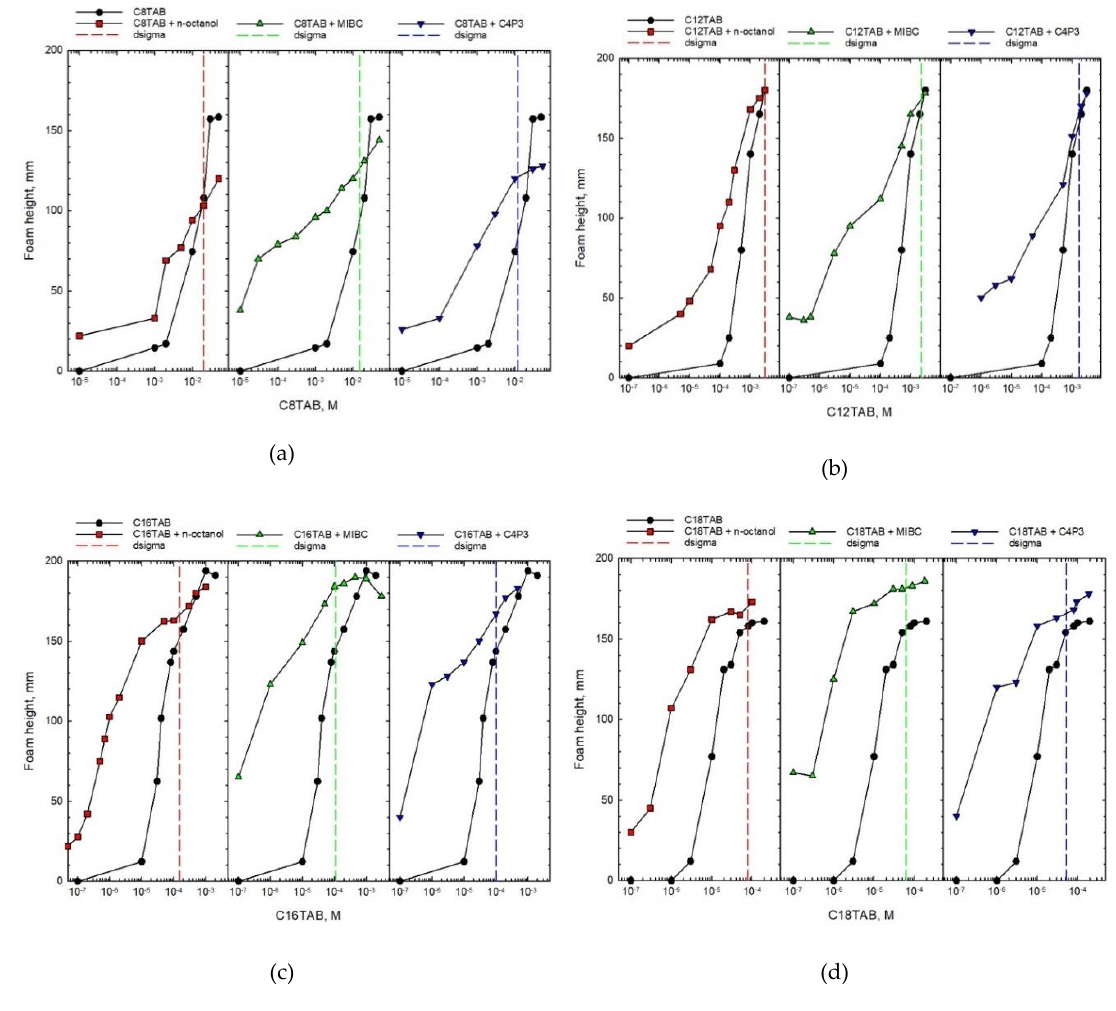
Figure 2. Foam height as a function of concentration of one-component solution and mixture of C n TAB (main component) with di ff erent non-ionic additives. The d σ (dsigma) values determined for each system are marked with vertical dashed lines.